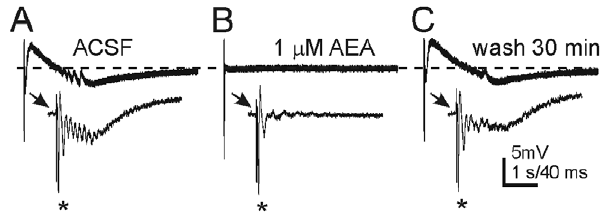
Figure 6. Anandamide attenuated secondary population activity that followed antidromic stimulation of granule cell axons. A . Trace showing granule cell response to mossy fiber stimulation in a mouse with TLE. B . Antidromically-evoked secondary afterdischarges were reduced in the presence of 1 m M AEA. C . The effect of AEA was reversible after 30 min wash to control ACSF. Recordings were made in the absence of Mg 2 + and the presence of 30 m M bicuculline; stimulus intensity 0.1 mA.